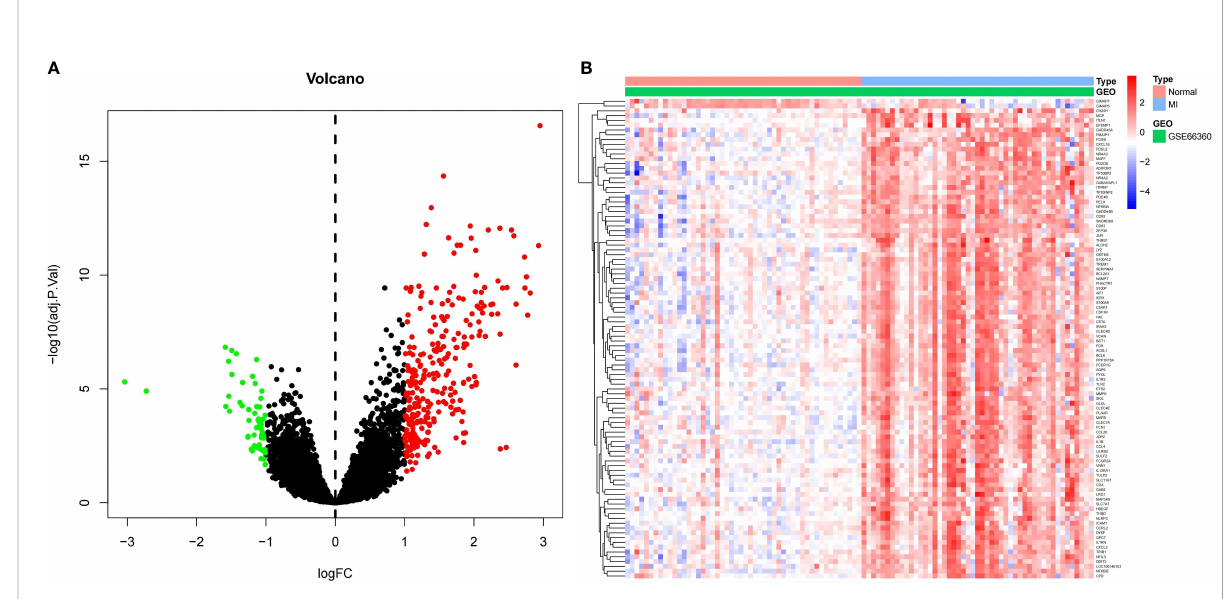
FIGURE 2 (A) Volcano plot for DEGs. Red dots indicate upregulated DEGs, and green dots express downregulated DEGs. (B) Heatmap for DEGs. Each line symbolizes one DEG, and each row represents one specimen. The red and blue swatches represent upregulated and downregulated DEGs,